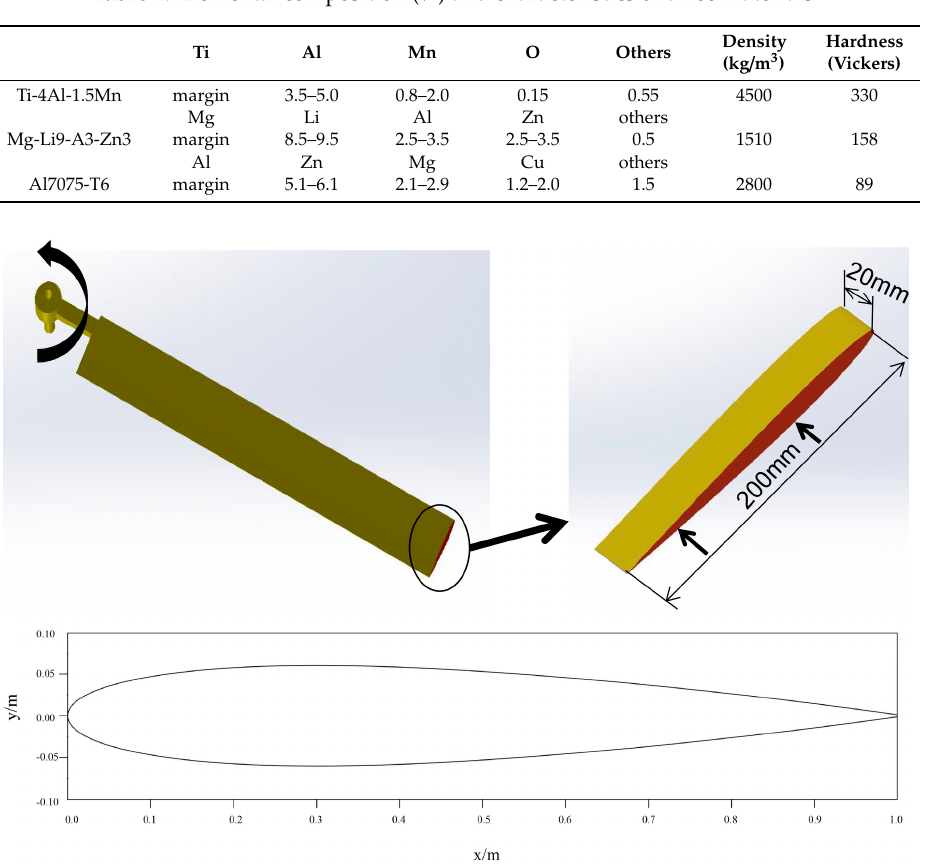
Figure 2. CFD model of the helicopter rotor blade: ( a ) boundary conditions; ( b ) mesh structure. Table 3. Results of mesh independence study. n